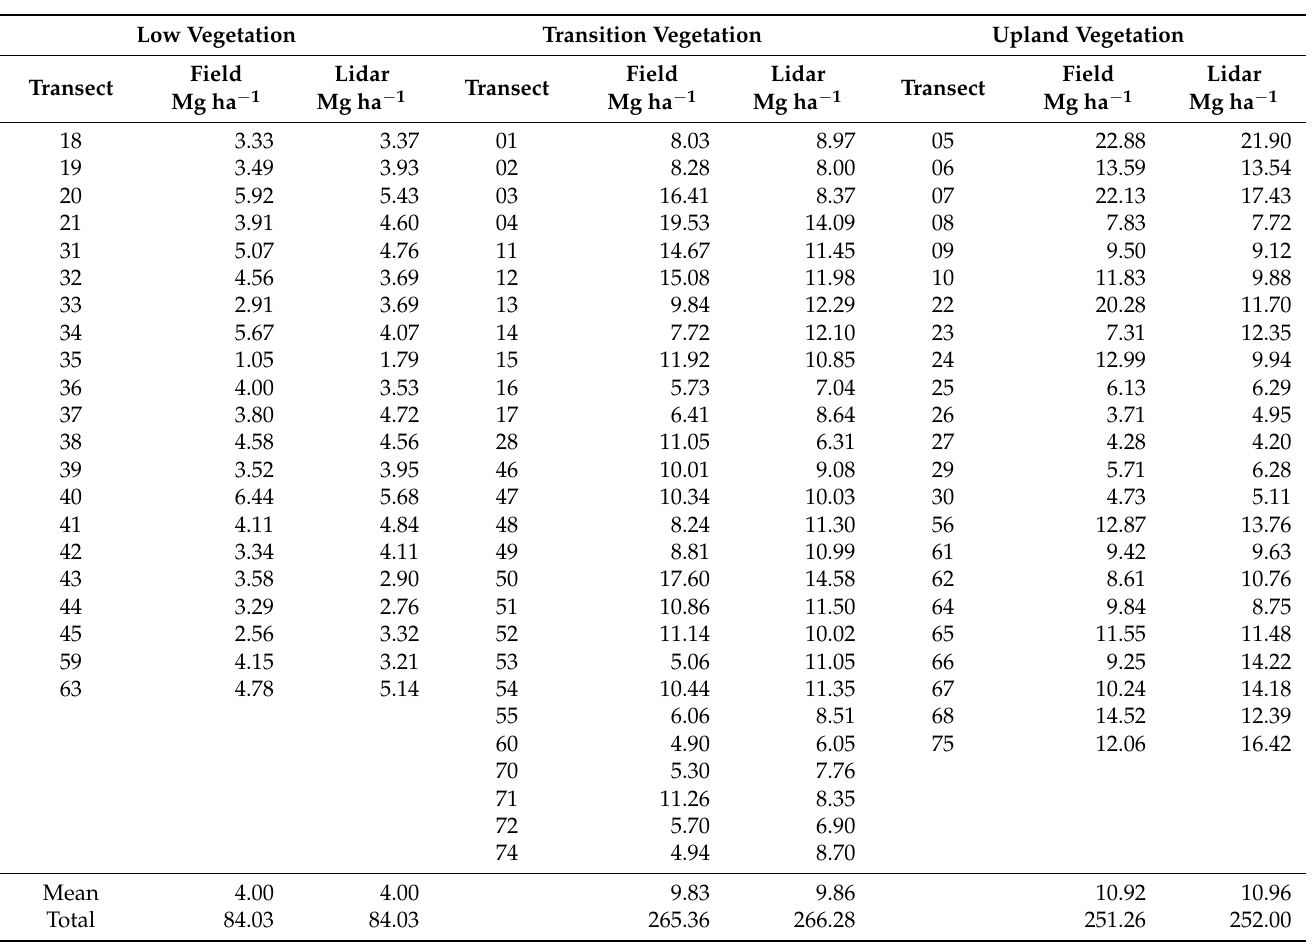
Table A2. Aboveground biomass estimates calculated by fieldwork survey and lidar predicted for each